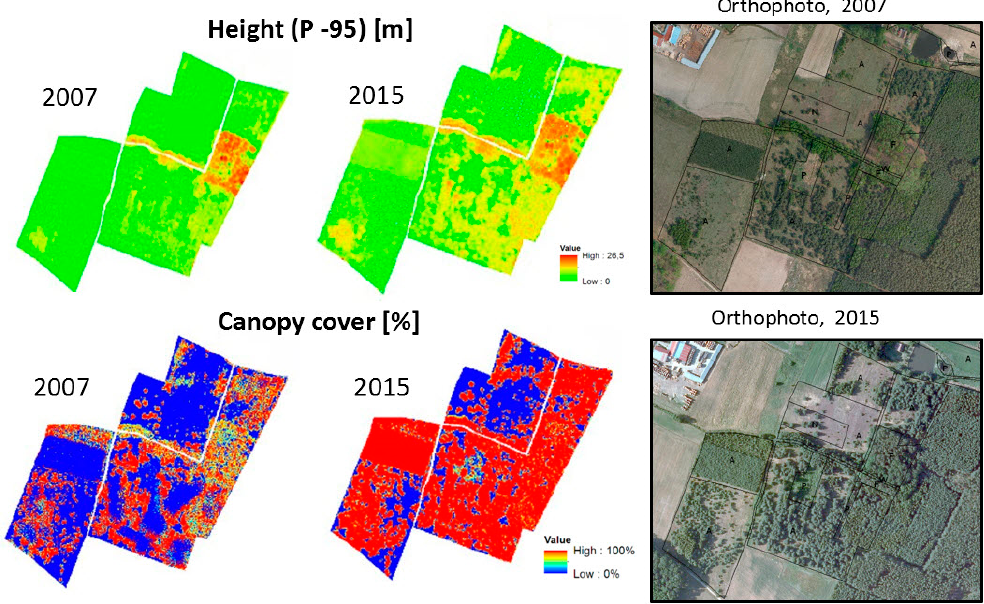
Figure 9. Part of the analyzed forest succession area—height of vegetation and canopy cover.